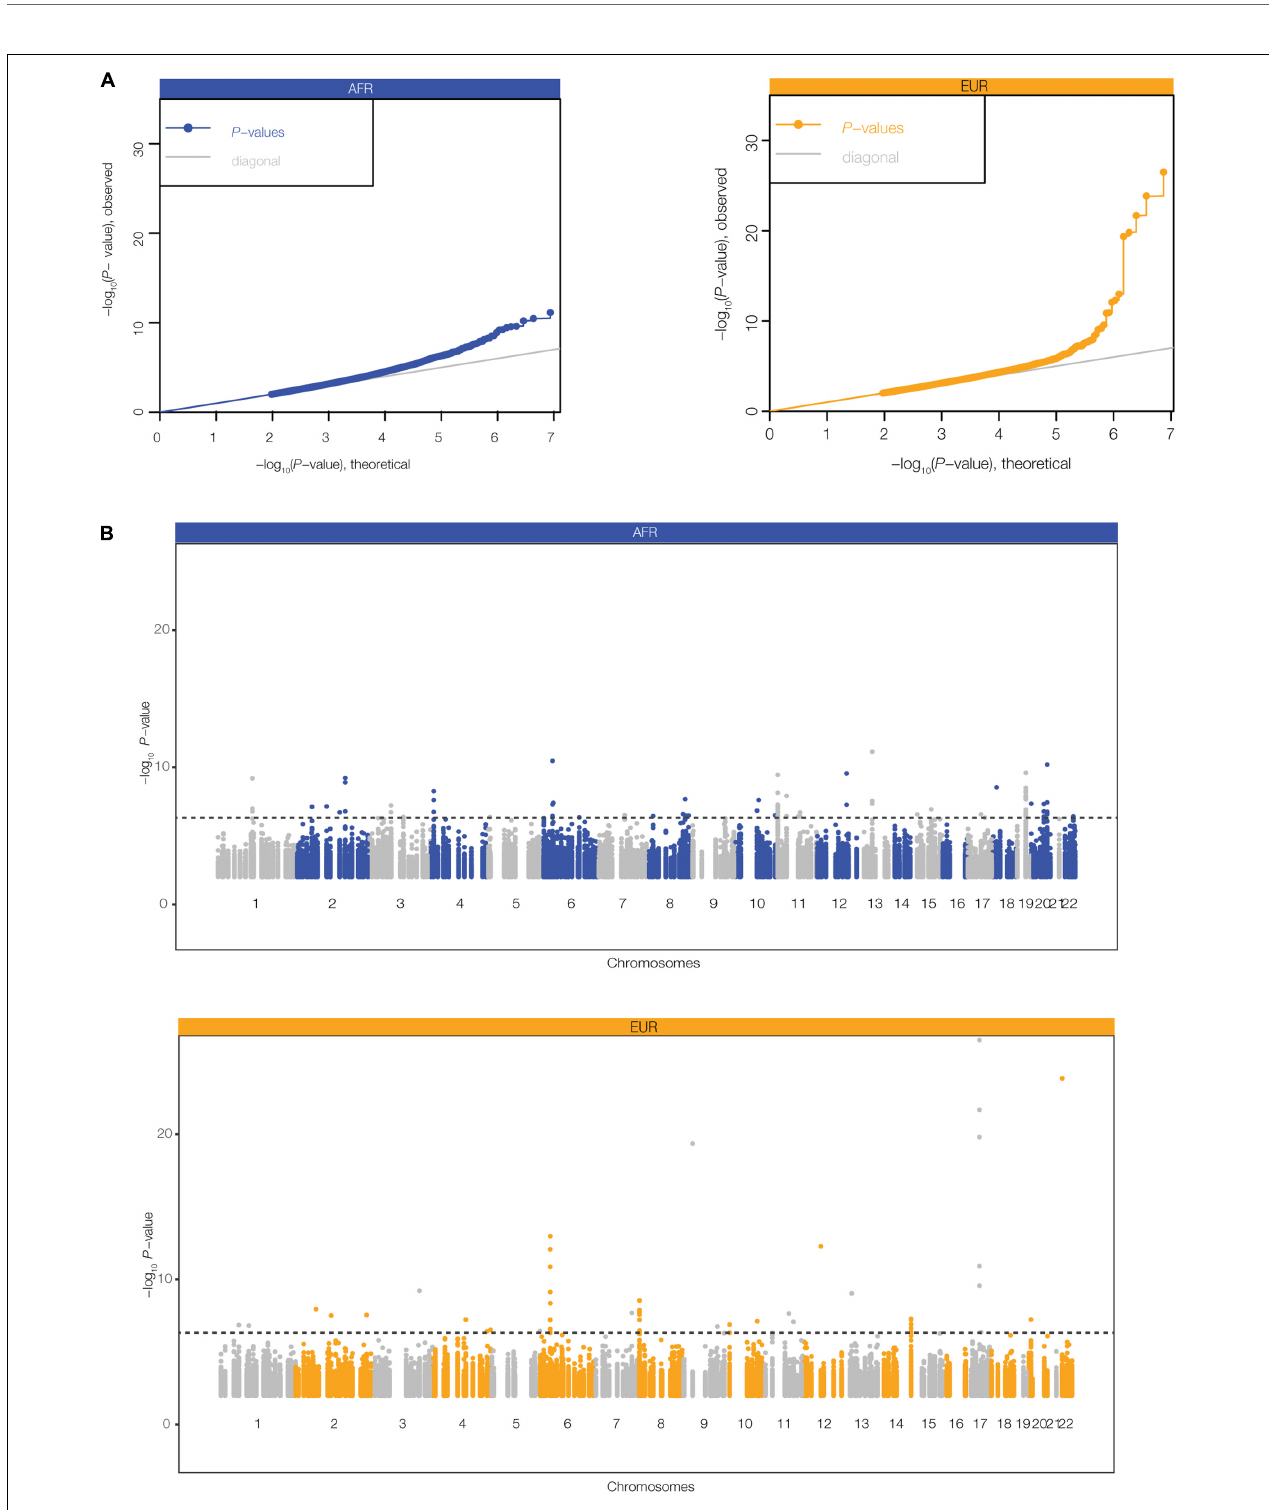
FIGURE 5 | Expression quantitative trait (eQTL) analysis for disease-linked polyTEs. eQTL analysis was performed by regressing lymphoblastoid gene expression levels against polyTE insertion genotypes for the for the African (AFR – blue) and European (EUR – orange) individuals analyzed here. (A) Quantile–quantile (Q–Q) plots relating the observed ( y -axis) to the expected ( x -axis) TE-eQTL log transformed P -values. (B) Manhattan plots showing the genomic distributions of TE-eQTL log transformed P -values. The dashed line corresponds to a false discovery rate (FDR) threshold of q < 0.05, corresponding to P = 4.7 × 10 − 7 (AFR) and P = 2.6 × 10 − 7